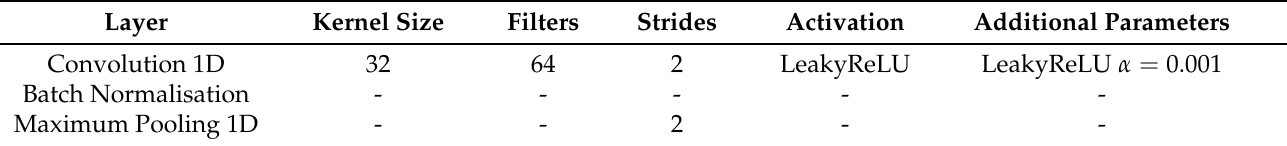
Table A3. The layer details of Block